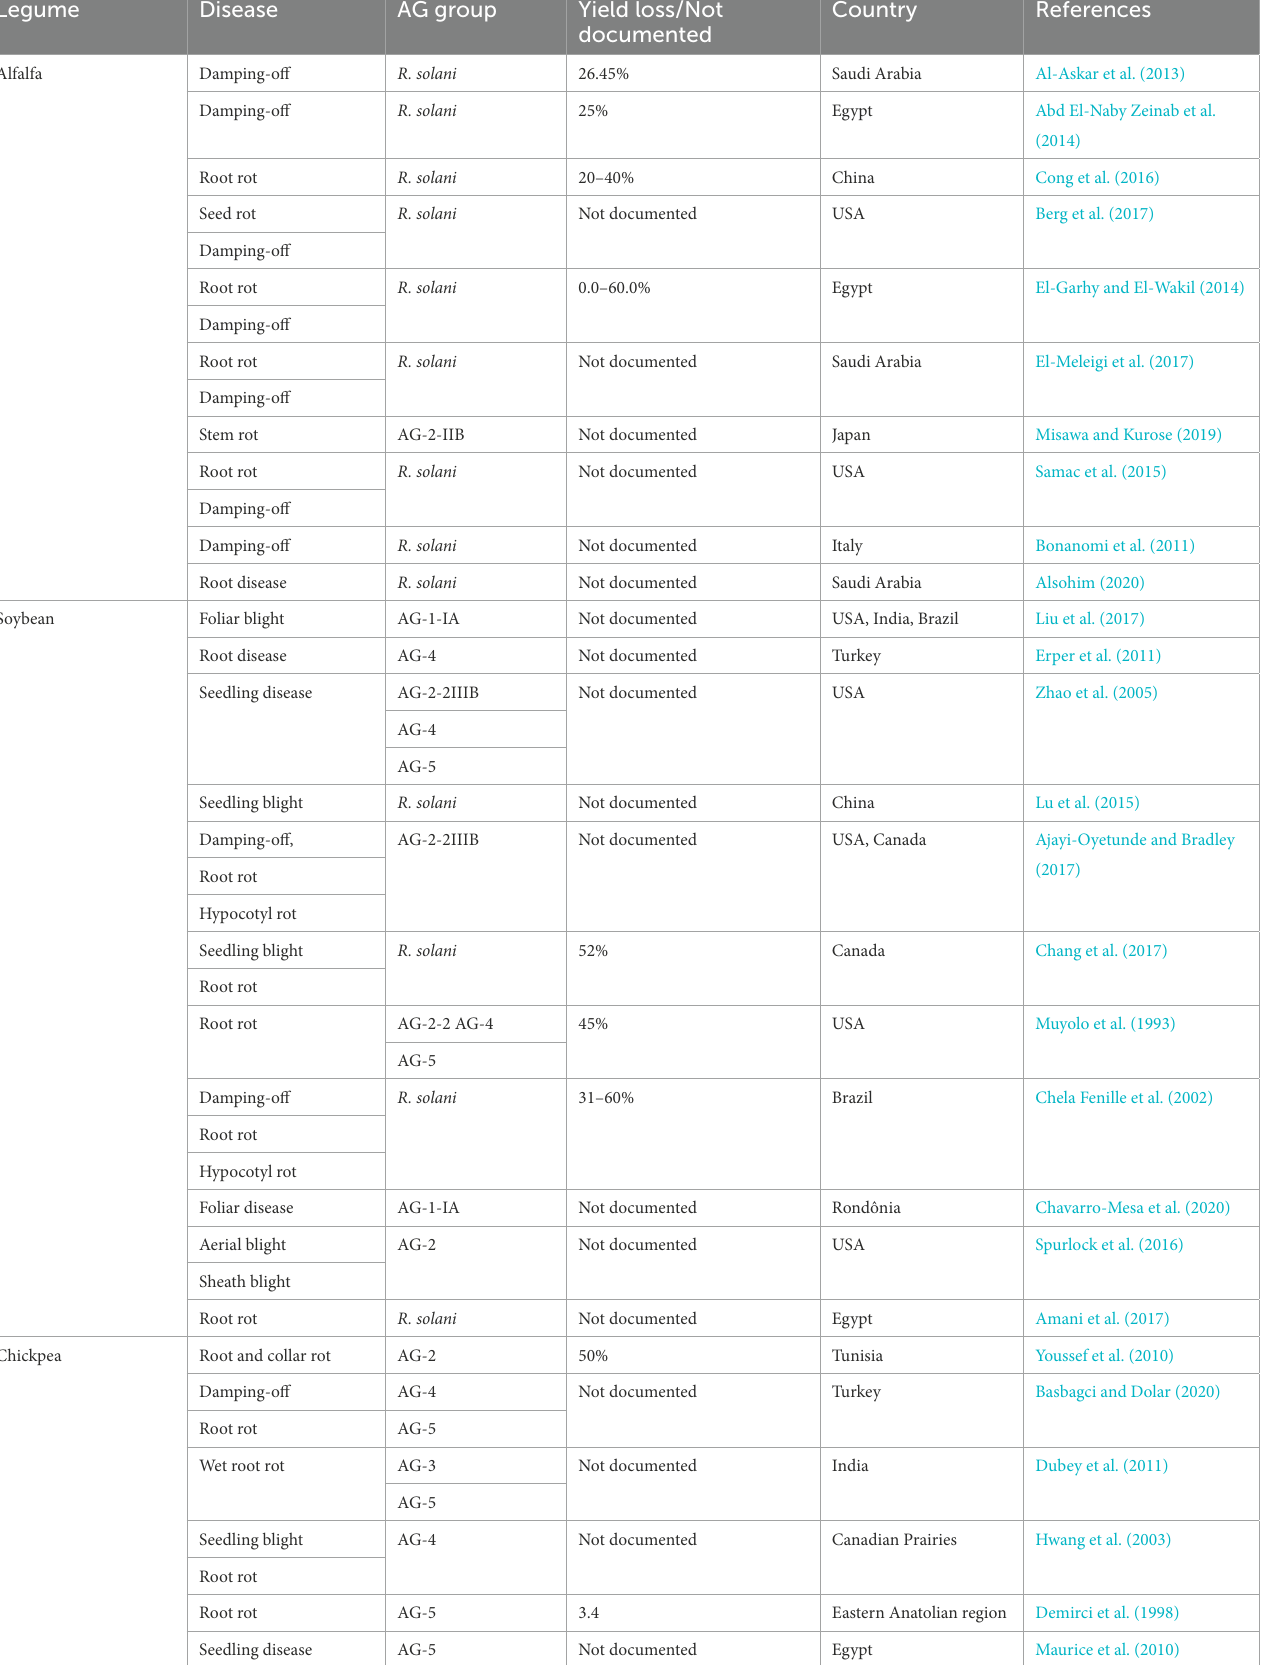
TABLE 1 Legume crops diseases caused by anastomosis groups of R. solani across different countries.